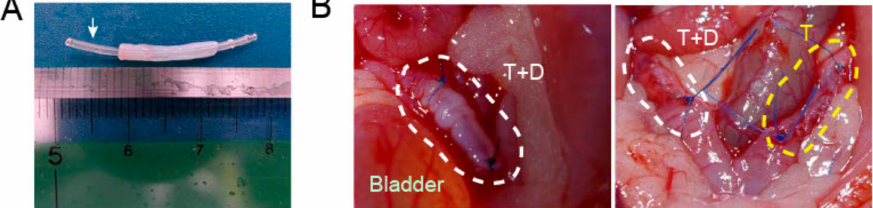
Figure 3. Placement of a silicone tube with or without a DES into endometrium-defective uterus in rats. ( A ) A silicon tube (white arrow) inserted into the lumen of cylindrical DES. ( B ) A tube alone (T) or tube-loaded DES (T+D) was placed into the endometrium-defective site of each uterine horn (circled by white and yellow dotted lines, respectively). The muscle layer and serosa were continuously